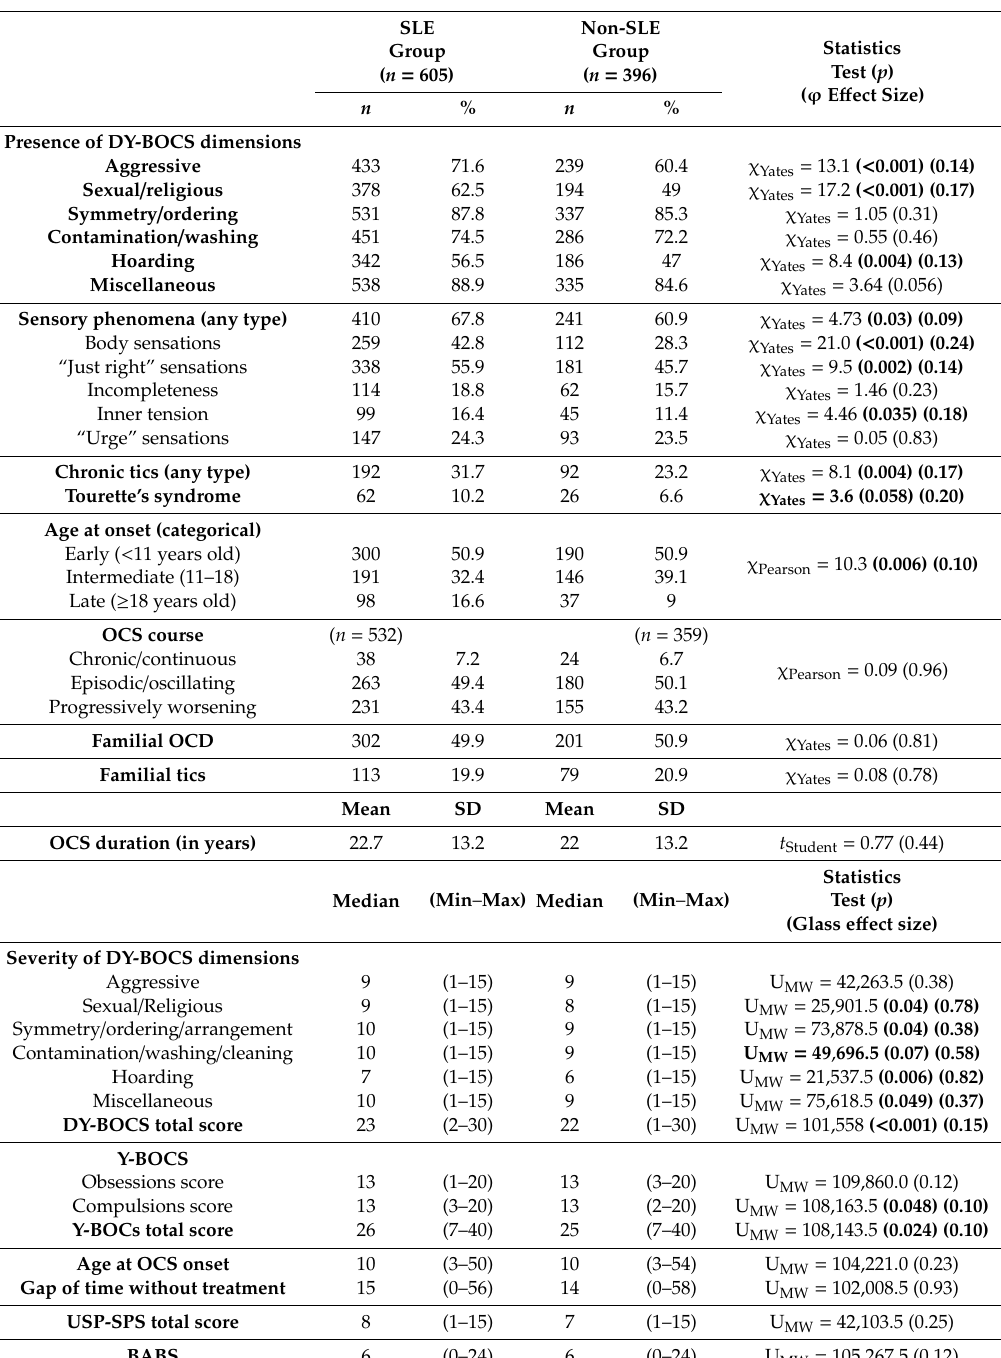
Table 2. Comparison of the intrinsic features of psychopathological obsessive–compulsive disorder (OCD) between the SLE and non-SLE